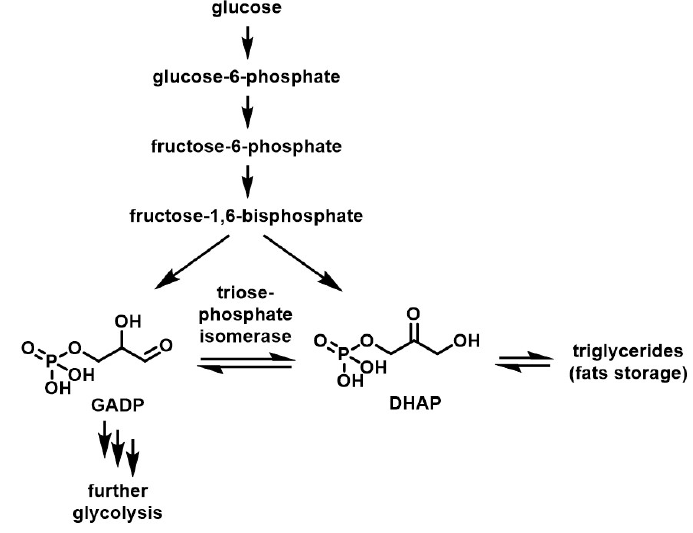
Figure 2. Simpli fi ed reaction path of the fi rst steps of glycolysis. Figure 2. Simplified reaction path of the first steps of